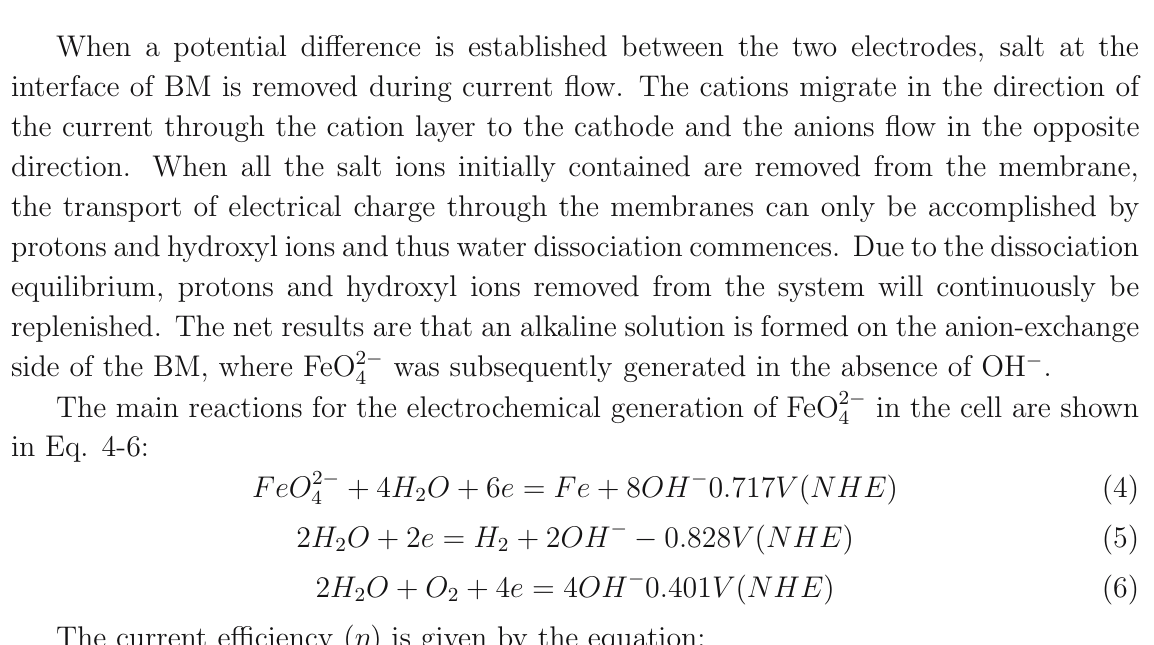
Fig. 1 Mechanism of electrochemical generation of FeO 42 − in electrolysis cell with SAMS- CMC-CS as